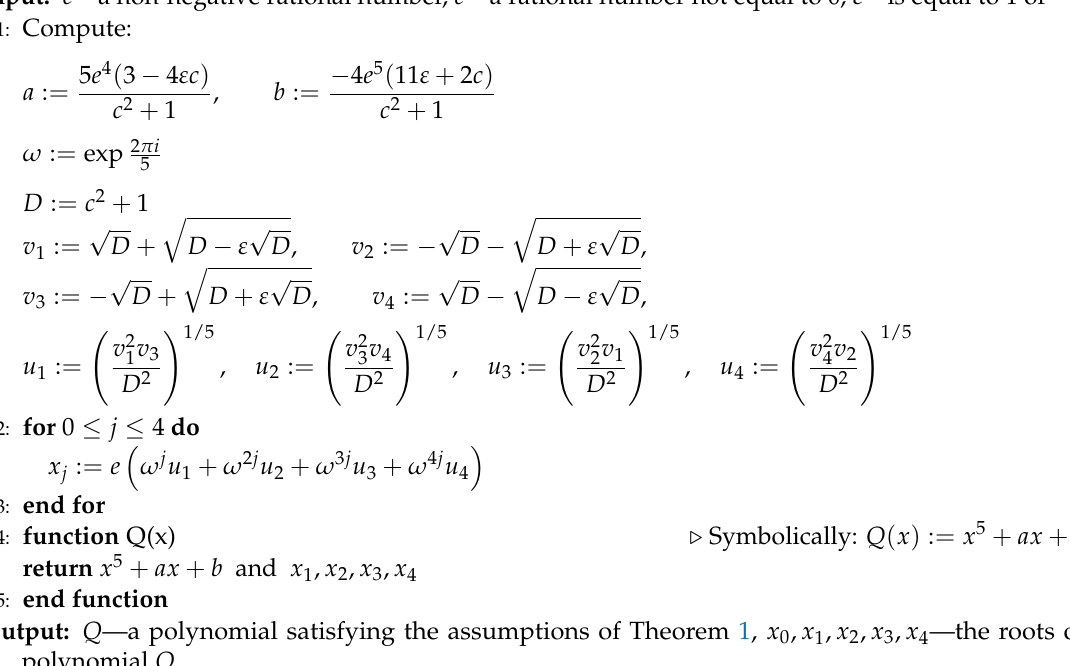
Algorithm 2 An algorithm generating polynomials that satisfy the assumptions of Theorem 1 and calculating their